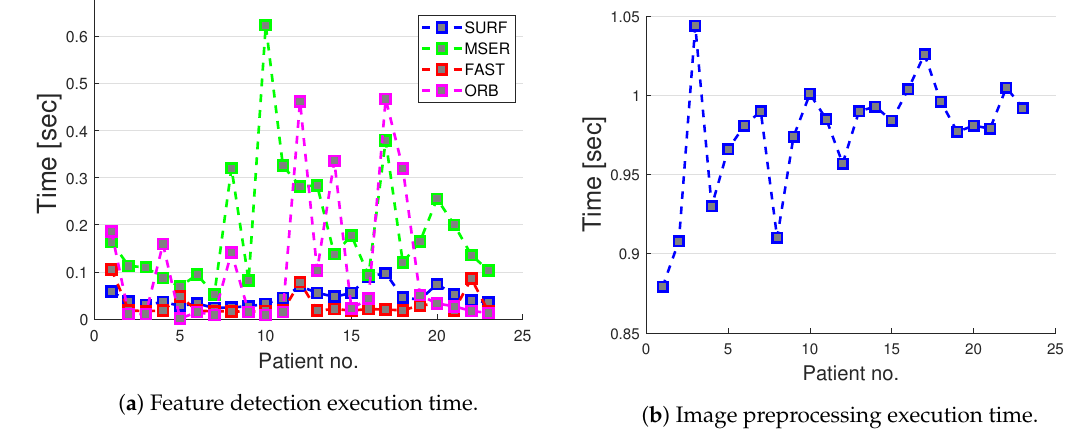
( a ) Feature detection execution time. Figure 13. Average execution time for different feature detection methods ( a ) and preprocessing time ( b ) in spine